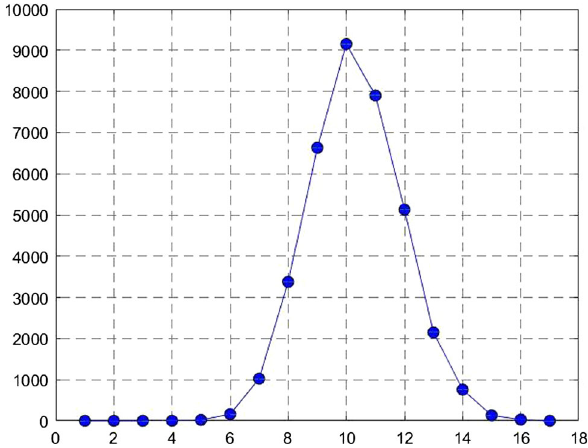
Fig. 3 The distribution of path lengths for a single 100-element causal set sprinkled in 2D Minkowski space